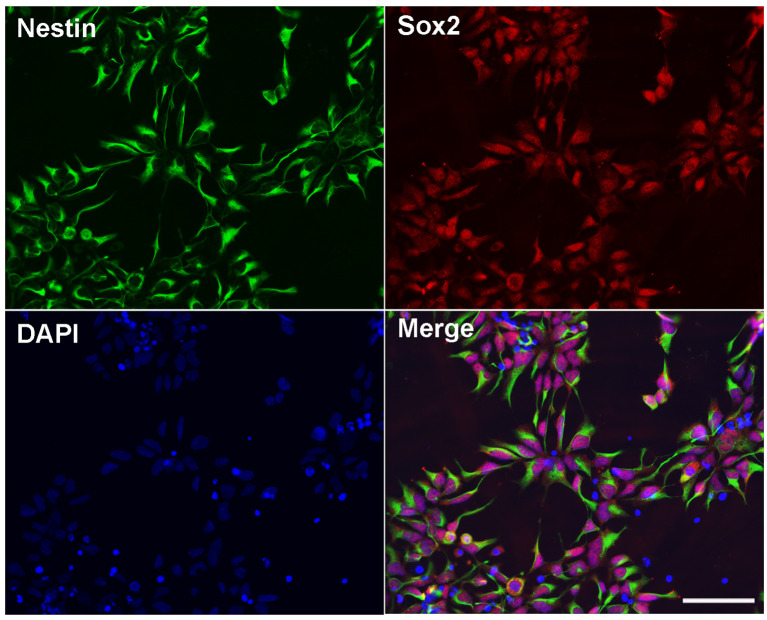
Identification of human embryonic stem cells (hESC)-derived neural progenitor cells (NPCs). Immunostaining images of hESC-derived NPCs showed anti-Nestin (green), Sox2 (red), and DAPI (blue). Scale bar = 50 μm.